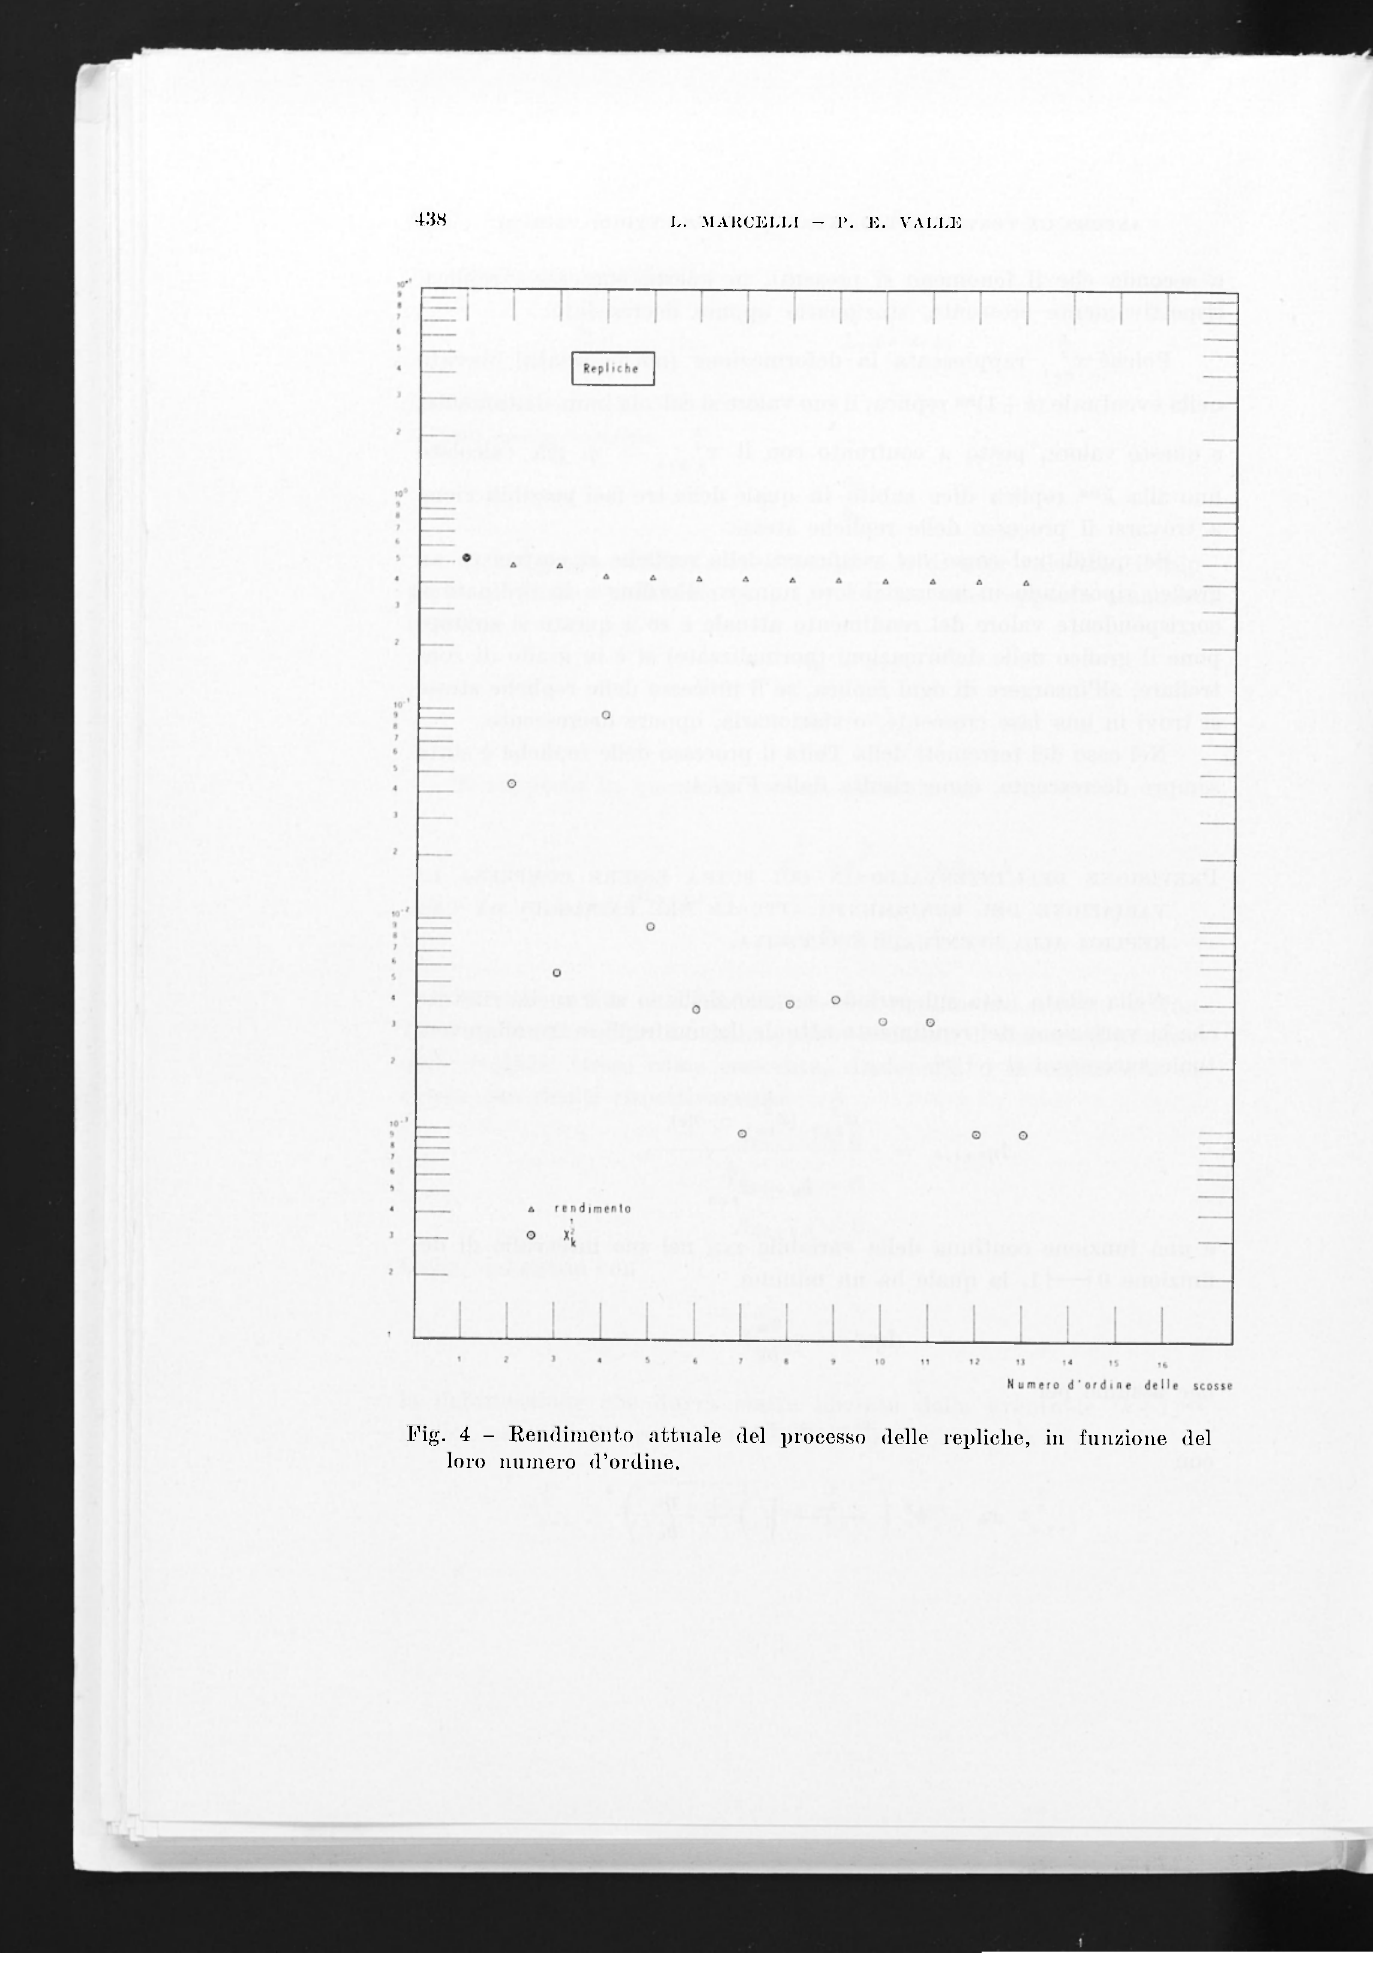
Fig. 4 - Rendimento attuale del processo delle repliche, in funzione del loro numero